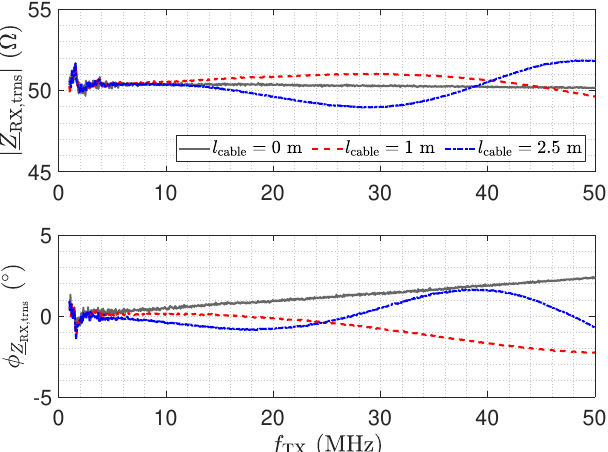
(cid:12) (cid:12) of the transformed input impedance (cid:12) Z RX,trns (cid:12) and phase φ Z RX,trns